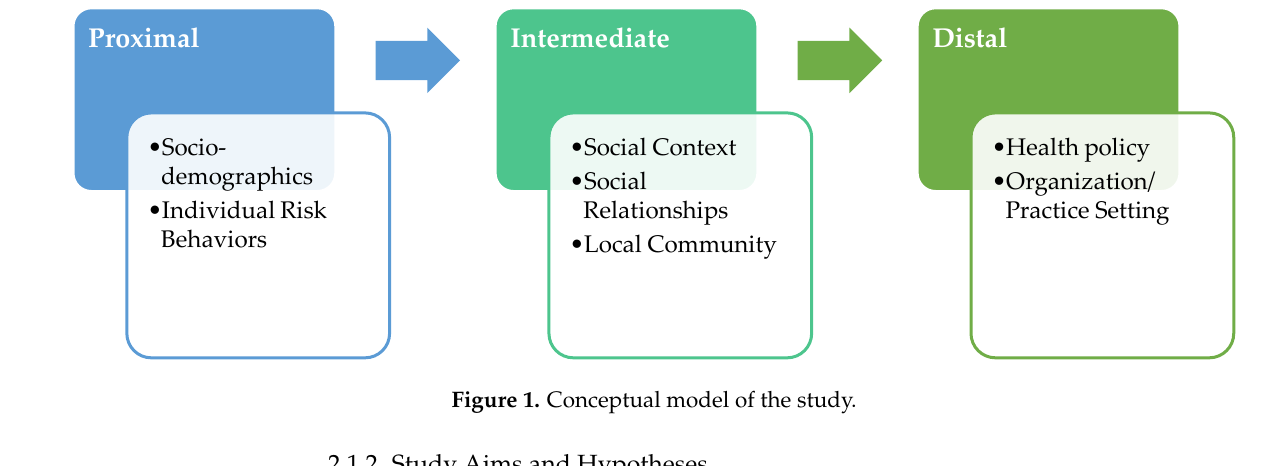
Figure 1. Conceptual model of the study.